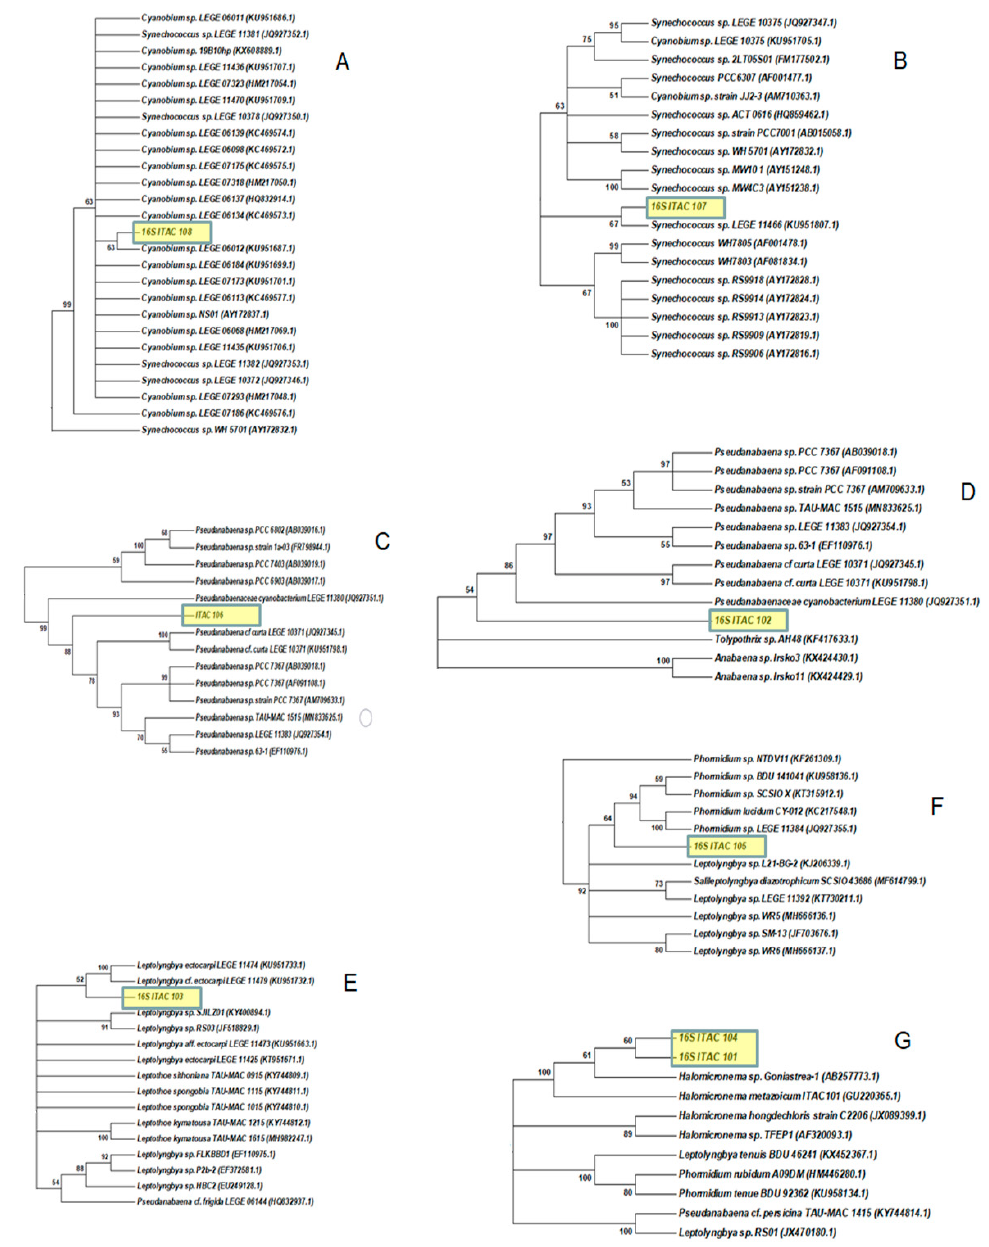
Figure 2. Phylogenetic relationships of the studied cyanobacteria strains based on 16S with other cyanobacteria taxa: ( A ) ITAC108; ( B ) ITAC107; ( C ) ITAC106; ( D ) ITAC102; ( E ) ITAC103; ( F ) ITAC105; ( G ) ITAC104 and ITAC101. The trees were constructed in MEGA7 using the Neighbor-Joining (NJ) method on a Jukes and Cantor distance matrix model. The robustness of the inferred phylogenies was determined by bootstrap analysis based on 1000 resamplings of data.